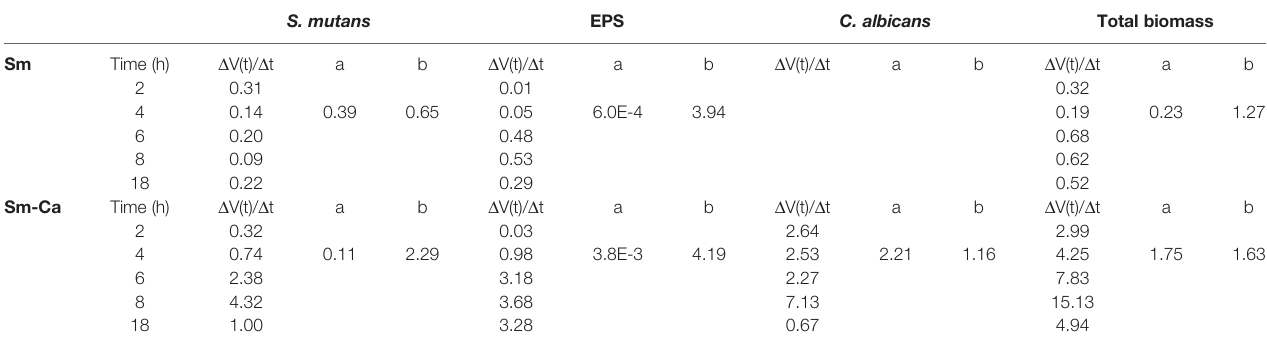
TABLE 1 | Quanti fi ed bio fi lm components of S. mutans single-species and S. mutans-C. albicans mixed-species bio fi lms and corresponding power-law